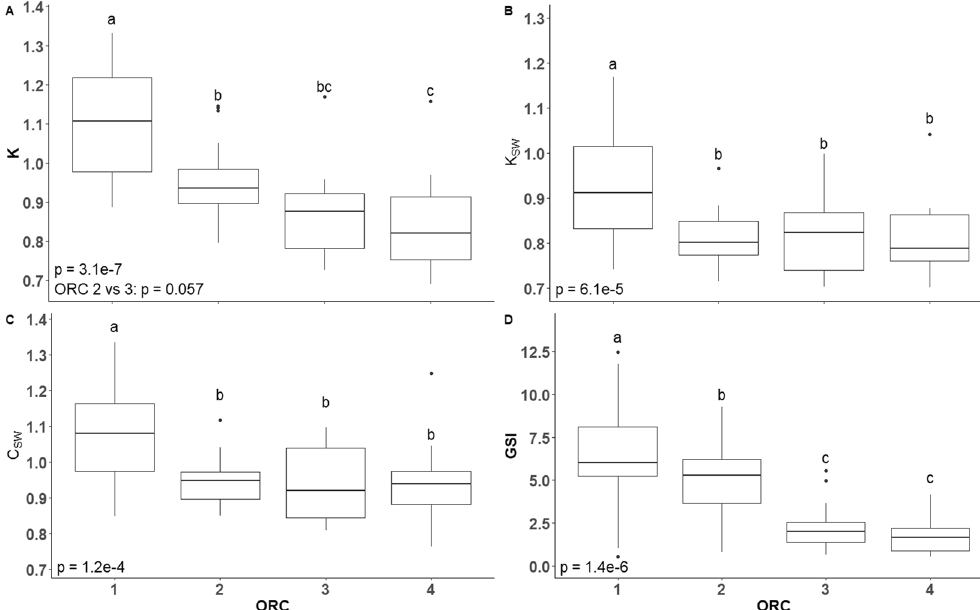
Figure 7. For female fish in each of the four ORCs, ( A ) Fulton’s condition factor (K), ( B ) K after the removal of ovarian influence (K SW ), ( C ) relative somatic condition (C SW ), and ( D ) gonadosomatic index (GSI). Different superscripts denote statistical significance, and the initial p-value is indicated on the lower left of each